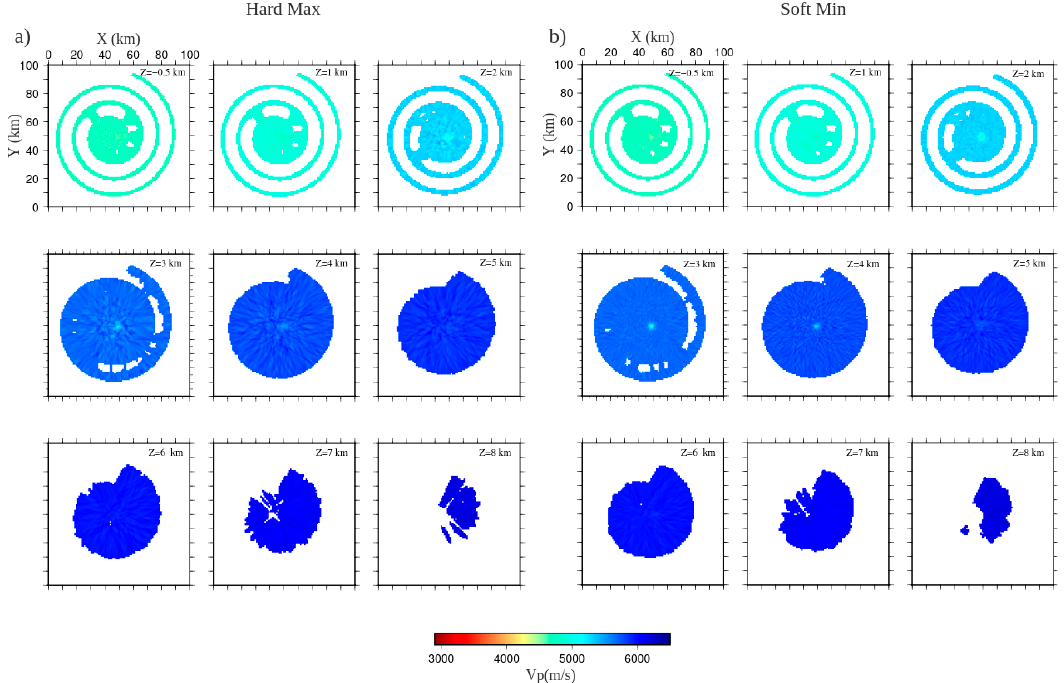
Figure 6. Example of retrieved tomographic models. Horizontal slice of tomographic model between 0.5 and 8 km in the case with rate 500 m 3 / day and D 1 m 2 / s, after one month of continuous injection and with two different catalogues: hard soil maximum noise level (HD MAX) ( a ) and soft soil minimum noise level (SF MIN) ( b ). Energies 2020 , 13 , x FOR PEER REVIEW